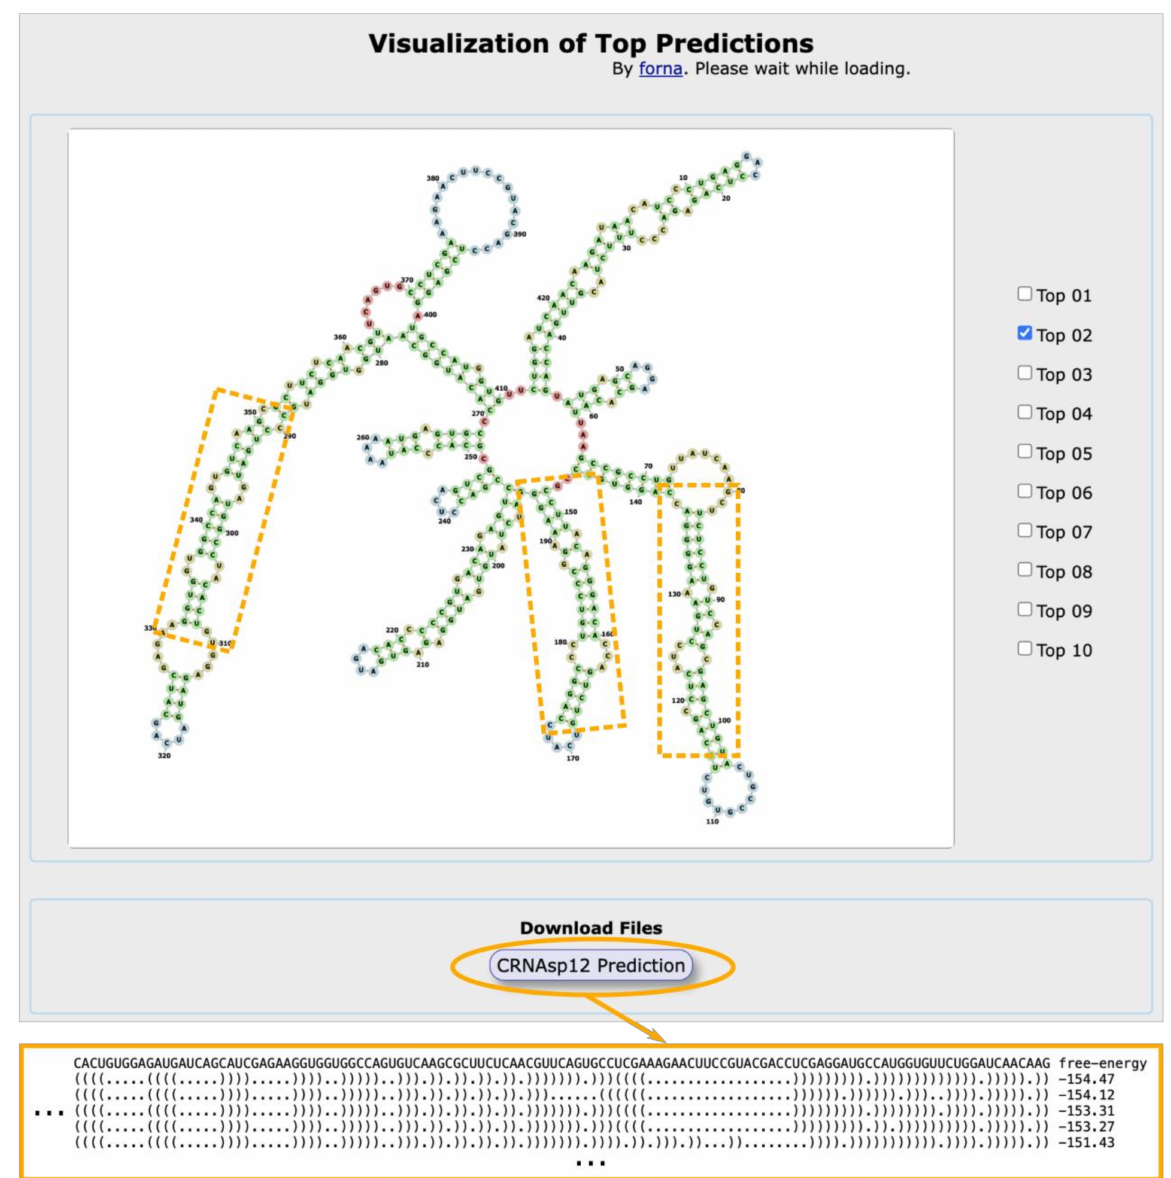
Figure 3. Snapshot of the output of the cRNAsp12 server. The model correctly predicts the three 16–26 bp dsRNAs, as indicated by the dashed rectangles, for the CAMSAP1